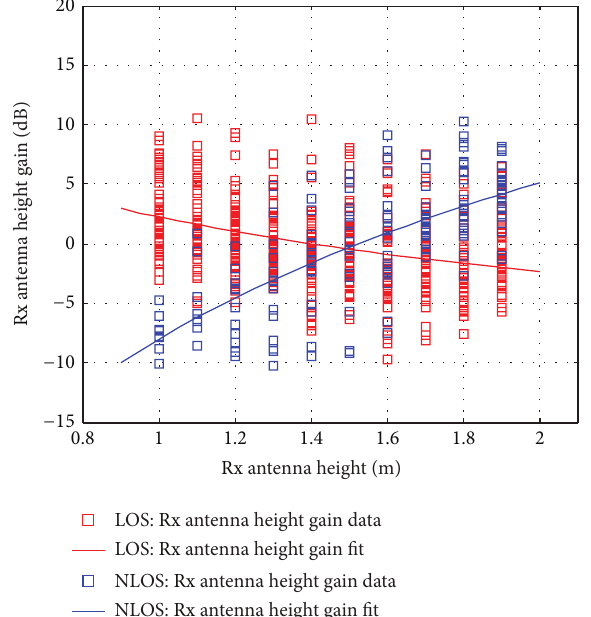
Figure 3: Fit of the Rx antenna height gain